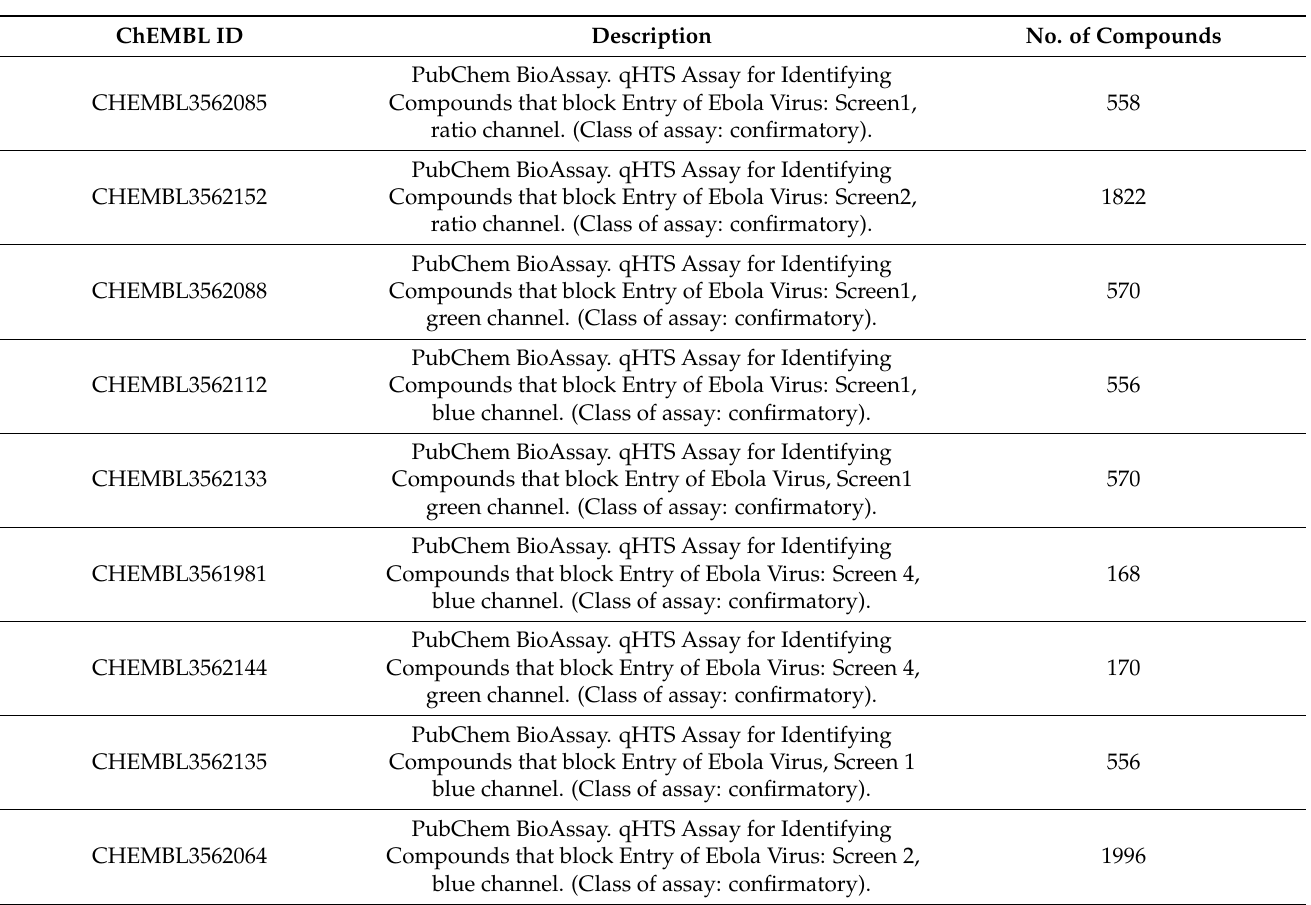
Figure 1. Schematic highlighting the integration of available resources and machine learning models (ML) to aid in potential anti-EBOV molecule prediction. Table 2. Ebola virus-related bioassay data available in ChEMBL [72]. The table consists of numbers of compounds, the description of the assays, and IDs. Assays with number of compounds less than 100 were